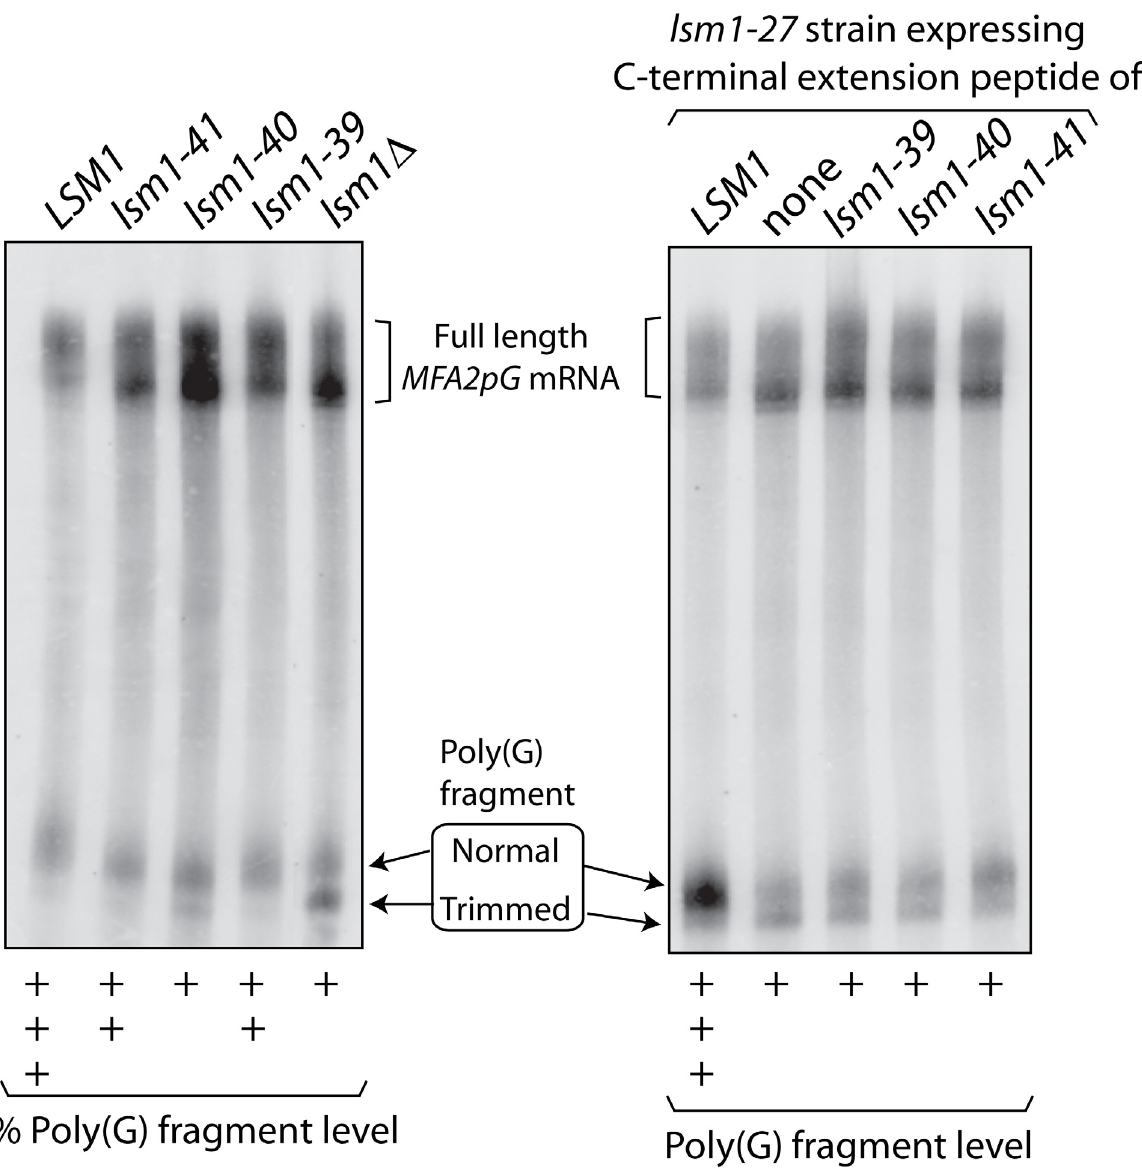
Fig 3. Effect of the C-terminal extension mutations of the lsm1-39 , lsm1-40 and lsm1-41 alleles on mRNA decay. RNA isolated from lsm1 Δ cells expressing wild type or various mutant alleles of LSM1 (left panel) or from lsm1-27 cells expressing wild type or various mutant versions of the C-terminal extension peptide of Lsm1 from multi copy 2 μ vectors (right panel) were subjected to Northern analysis to reveal the MFA2pG mRNA and the poly(G) fragment. Poly(G) fragment levels were approximated and presented as described in the legend for Fig